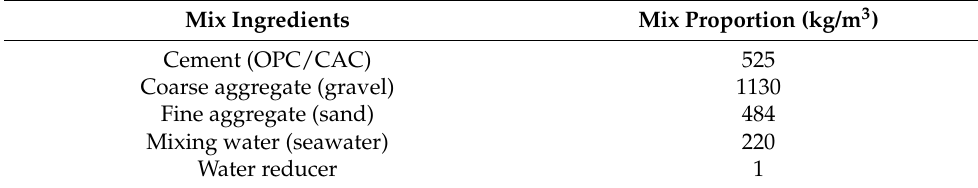
Table 1. Mix proportion of two sets of seawater concrete. Mix Ingredients Mix Proportion (kg/m 3 )